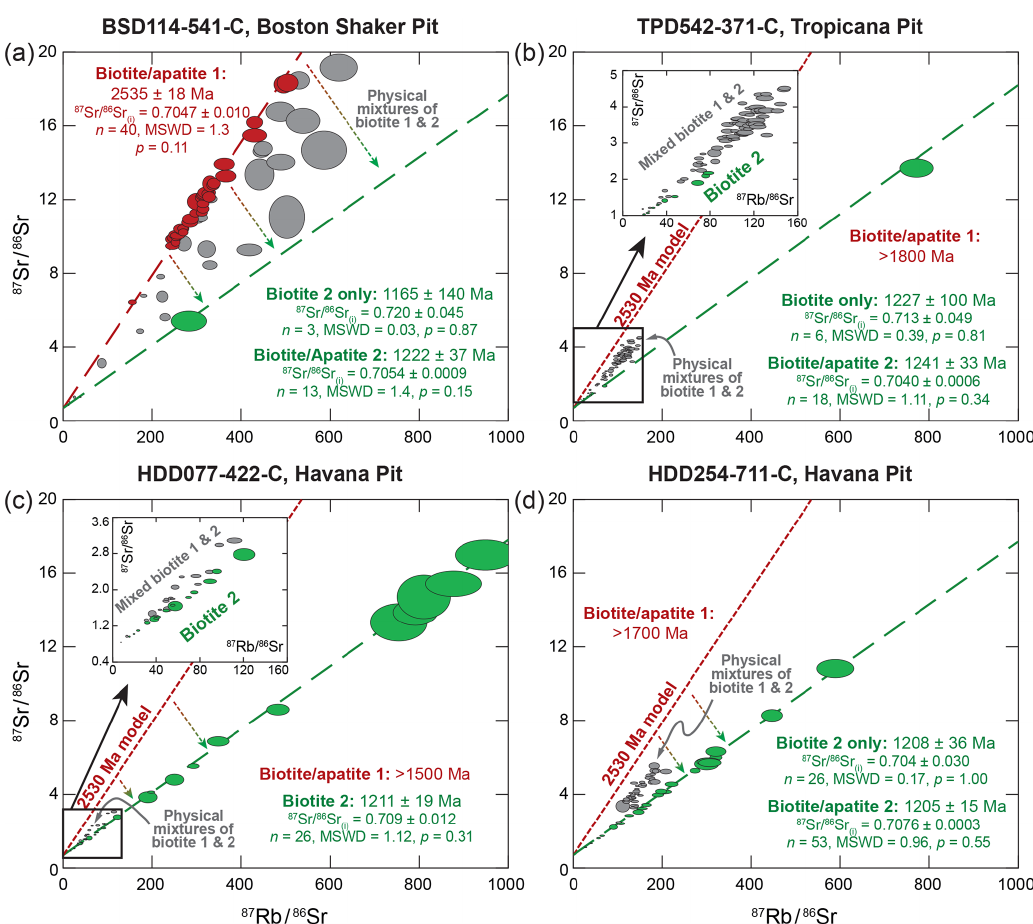
Figure 6. Biotite Rb–Sr isochrons for individual samples, with red data corresponding to assemblage 1 and green data corresponding to assemblage 2 biotite. Gray data are considered to be part of assemblage 1 but with loss of radiogenic Sr. In samples where only disturbed biotite 1 exists, only a minimum age can be estimated based on a broad isochron through the oldest analyses. All error ellipses are plotted at 2 σ . The 2530Ma model age is based off Fig. 4a, assuming an initial 87 Sr / 86 Sr of 0.7045. Note that ages are calculated both solely with biotite 2 and with biotite 2 and apatite combined for assemblage 2 (see Sects. 3 and